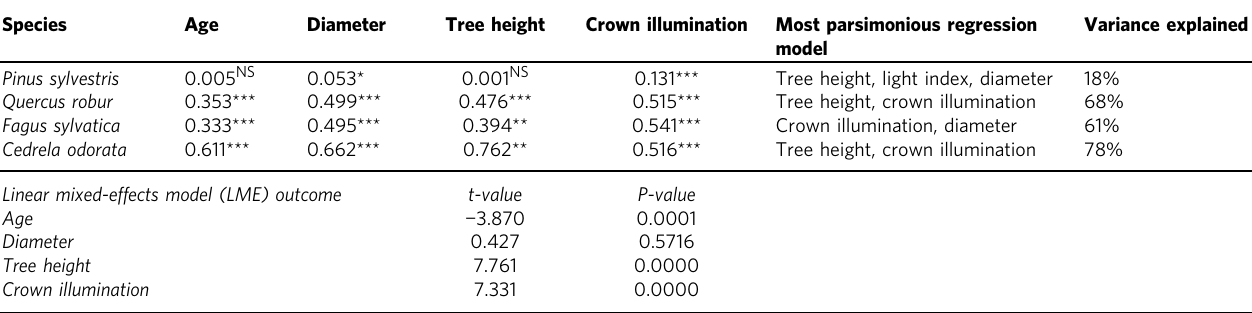
Table 2 Effects of tree age, diameter, height and crown illumination on intrinsic water use ef fi ciency Species Age Tree height Crown